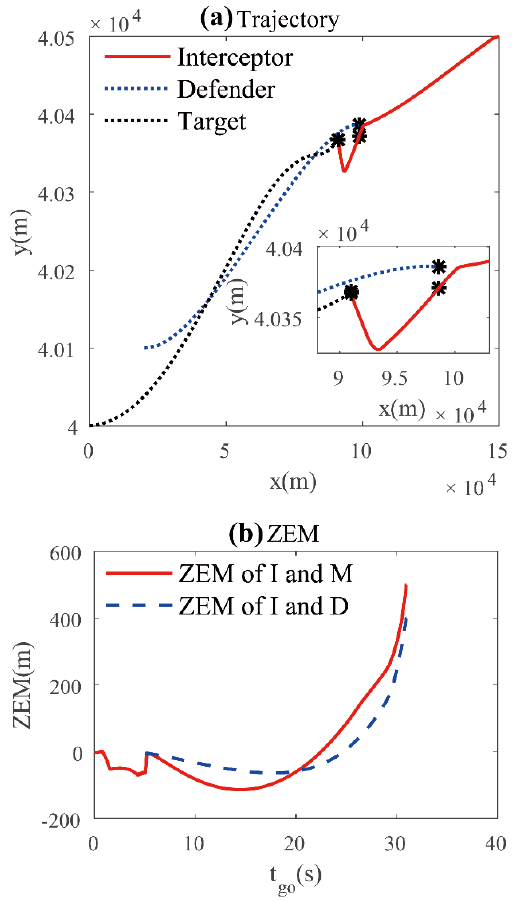
Figure 5. Simulation results of Case 3: ( a ) trajectory; ( b ) ZEM.